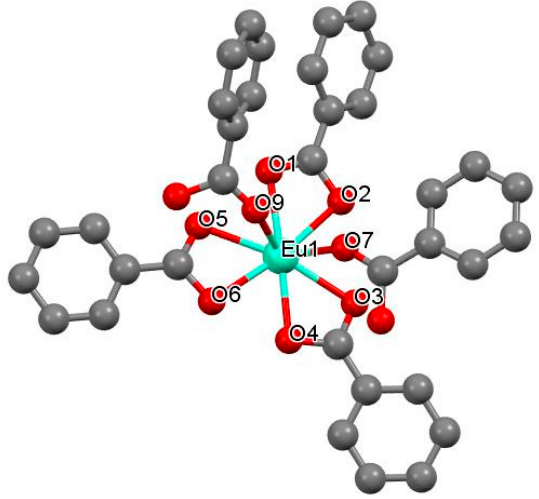
Figure 7. Crystal structure of complex 3 : [Eu(OOCC 6 H 5 ) 3 · (HOOCC 6 H 5 ) 2 . Hydrogen atoms are omitted for clarity.